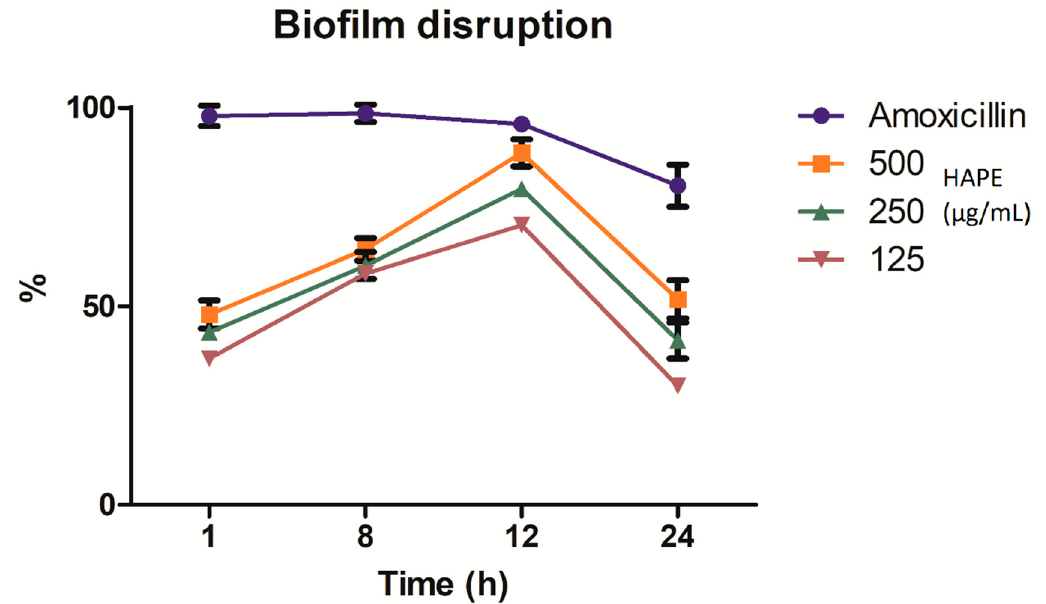
Figure 4. Time-concentration Listeria monocytogenes biofilm disruption by acid-microwave hydrolyzed avocado peel extract (HAPE) at different intervals of time (1, 8, 12, and 24 h) at different concentrations (500, 250, and 125 µg/mL) and amoxicillin (positive control) incubated at 37 °C.